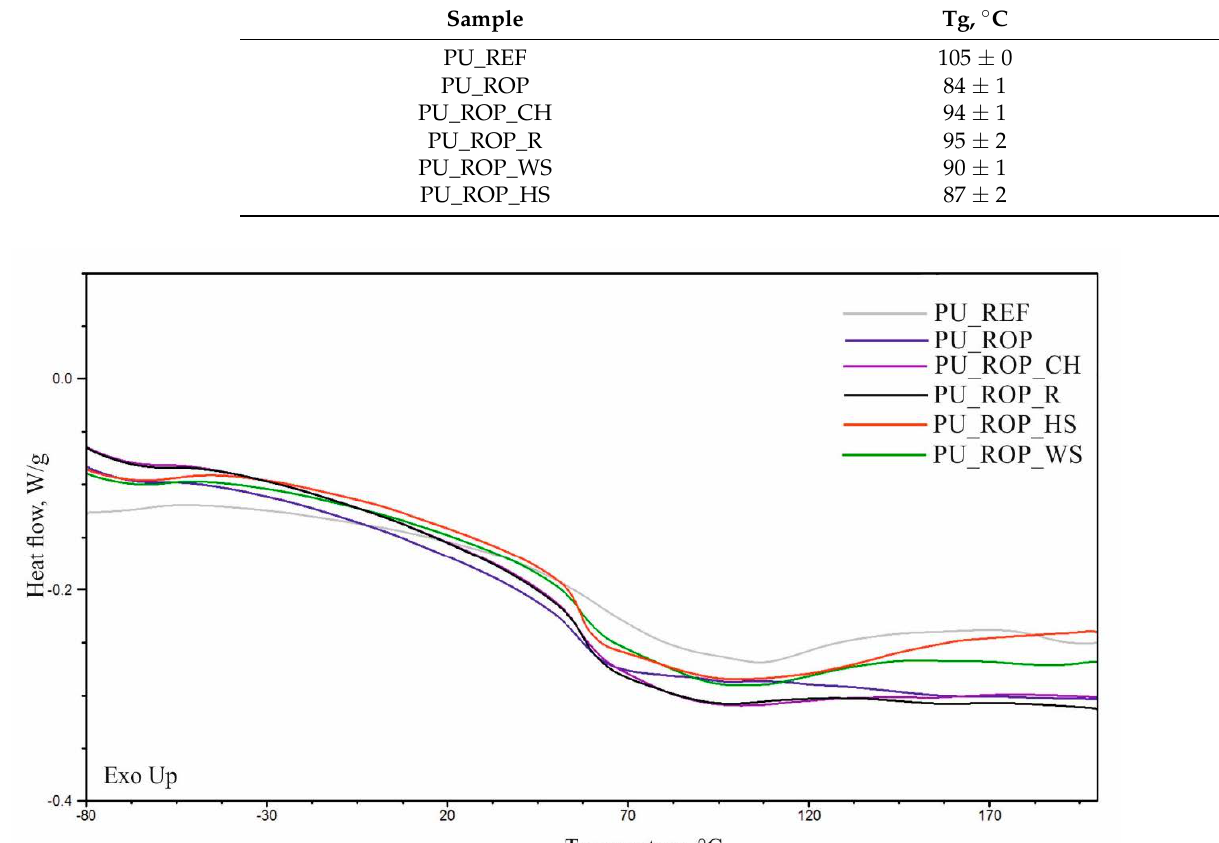
Table 5. The results of the DSC curve analysis of the examined materials.